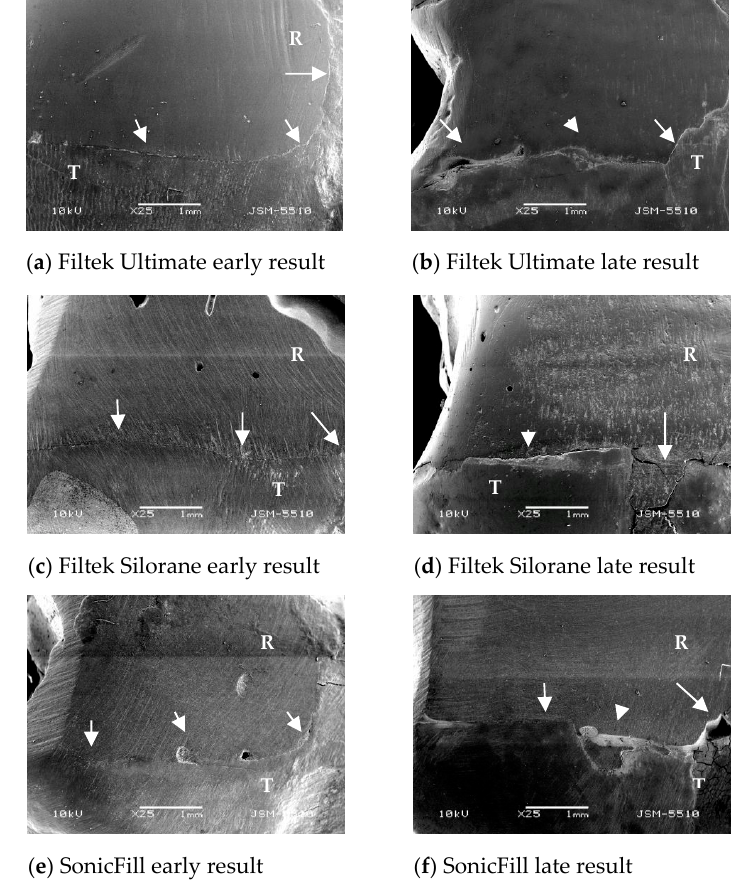
Figure 6. Illustrative comparison between early and late results of marginal adaptation (SEM); R = restoration; T = tooth structure; Arrows are pointing restoration margin. More discrepancies can be seen with the late results ( b , d , f ).